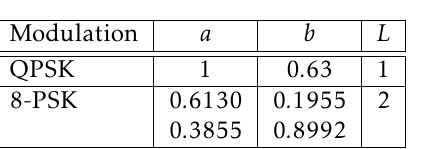
Table 1. Approximation parameters of (37) for QPSK and 8 - PSK modulations.